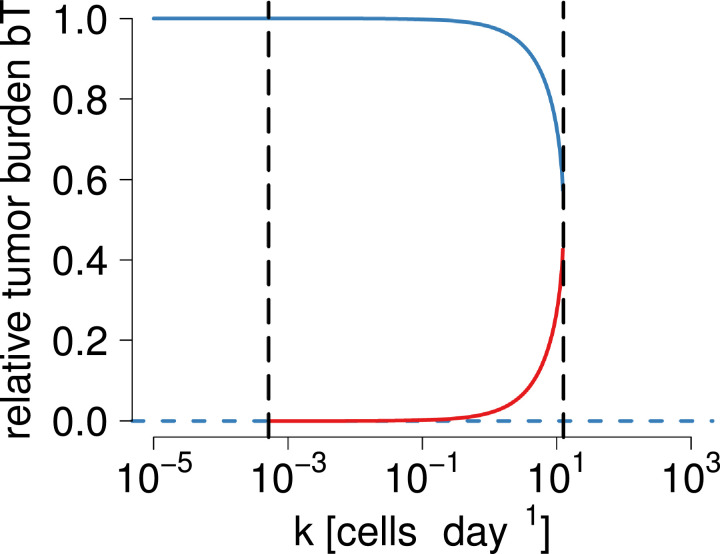
Bistability of immune control of tumor growth. Increasing values of k lead to the emergence of a bifurcation in equilibrium tumor cell numbers. The emergence of the bifurcations is indicated by black, vertical dashed lines. The upper blue line shows the largest stable steady states and the lower dashed blue line shows the smallest of the steady states, while red lines show unstable steady states for a given k value. If bT is one, the cancer has reached carrying capacity. At bT=0, no cancer cells exist. Thus, above a threshold value ku, the cancer is cleared. The parameter values are m=−10−6,σ=10 (Althaus, De Boer, 2008, De Boer, 2007), d=2×10−2 (Ogg, Kostense, Klein, Jurriaans, Hamann, McMichael, Miedema, 1999, Casazza, Betts, Picker, Koup, 2001), a=0.514 (de Pillis et al., 2005), b=1.02×10−9 (de Pillis et al., 2005). (For interpretation of the references to colour in this figure legend, the reader is referred to the web version of this article.)